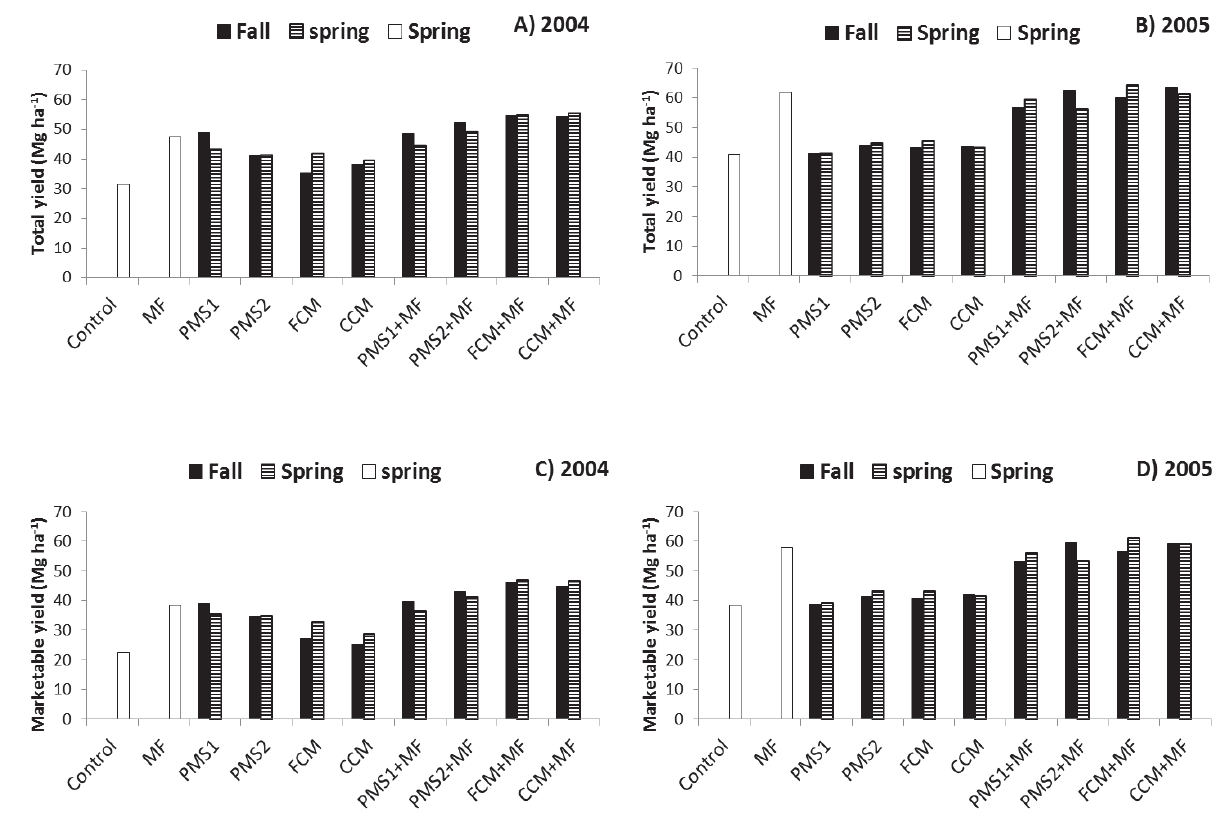
Figure 2. Effects of mineral N fertilization and organic amendments with or